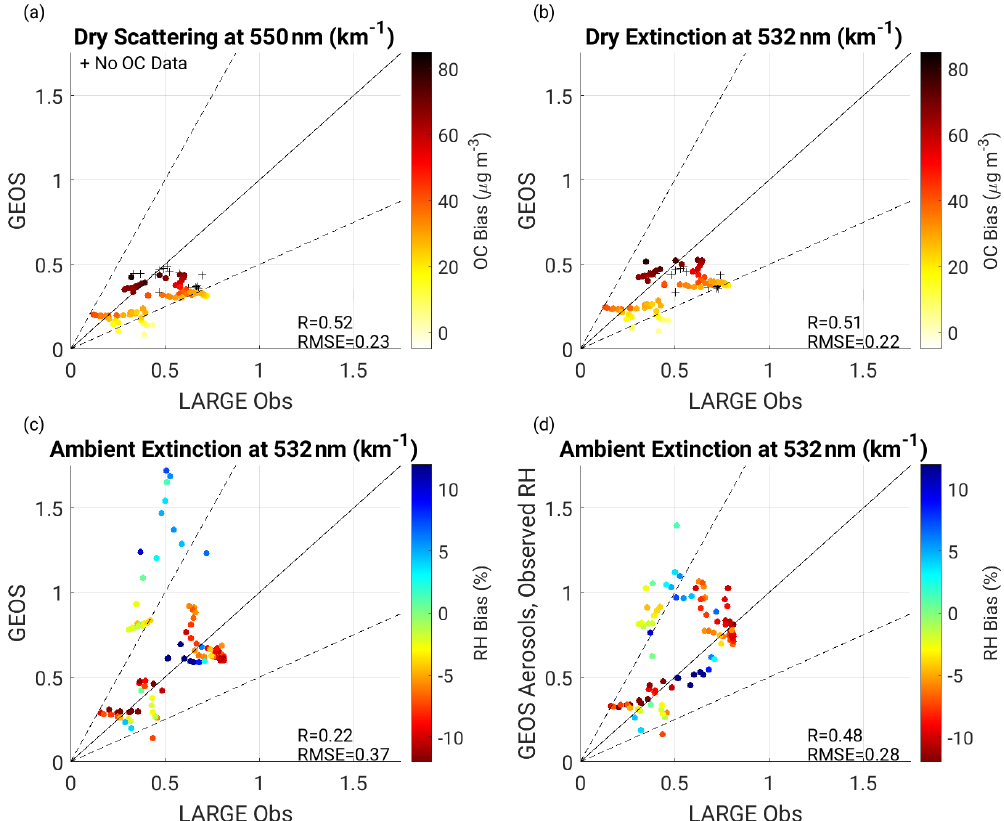
Figure 9. Scatter plot of observations from LARGE versus GEOS GOCART2G for (a) dry scattering at 550nm, (b) dry extinction at 532nm, (c) ambient extinction at 532nm, and (d) ambient extinction at 532nm with bias-corrected relative humidity in GEOS. Panels (a) and (b) are colored based on the bias in organic carbon mass concentration, and panels (c) and (d) are colored based on the bias in relative humidity. The solid black line represents the one-to-one line, while dashed black lines are the two-to-one